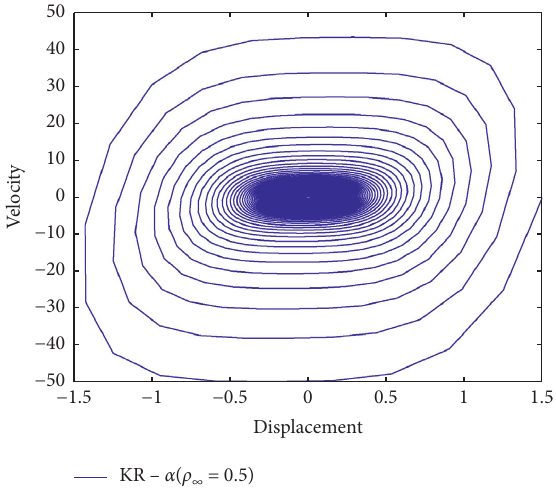
Figure 20: Phase portrait of the hardening spring calculated using � 0 . 5 ) when Δ t � T the KR- α method ( ρ ∞